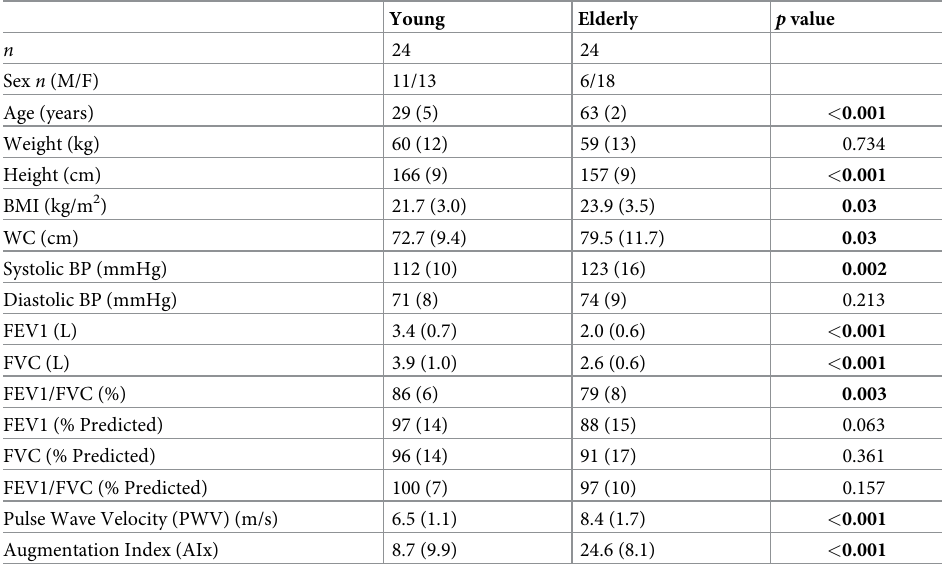
Table 1. Mean and (standard deviation (SD)) of participant demographics.